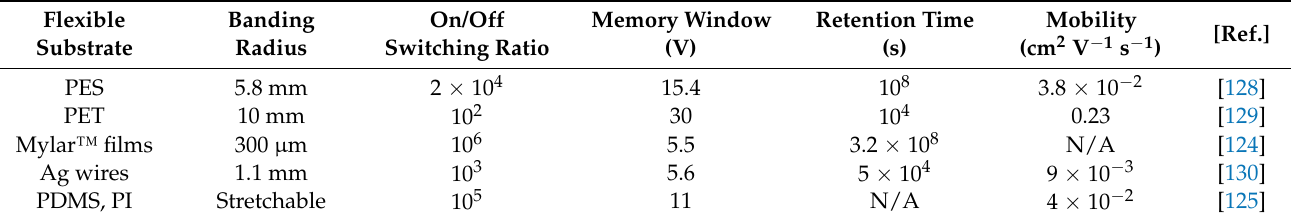
Table 6. Flexible memory characteristics